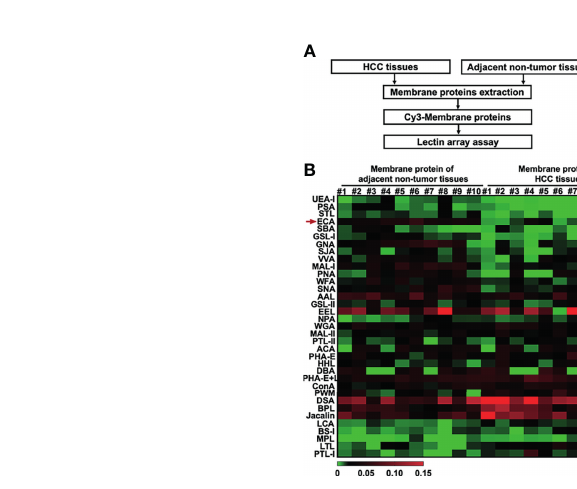
FIGURE 1 | Lectin array and immuno fl uorescence analysis of glycopatterns on membrane proteins of HCC tissues and adjacent non-tumor tissues. (A) Work fl ow of the strategy for the determination of differentially expressed membrane glycopatterns in HCC tissues compared with adjacent non-tumor tissues. (B, C) Expressions of glycans on the membrane proteins between HCC tissues and adjacent non-tumor tissues analyzed by 35 different lectins presented as a heatmap (B) and Venn diagram (C) . #1 to #10: 10 HCC patients; (D, E) Immuno fl uorescence analysis of fl uorescence intensity of glycans binding with ECA on cell membrane proteins between HCC and adjacent non-tumor tissues. Images are stained as FITC-conjugated ECA (green, membrane) and DAPI (blue, nuclei). Fluorescent intensities in (E) are presented as the mean ± SD using unpaired Student ’ s t-tests (*** p <